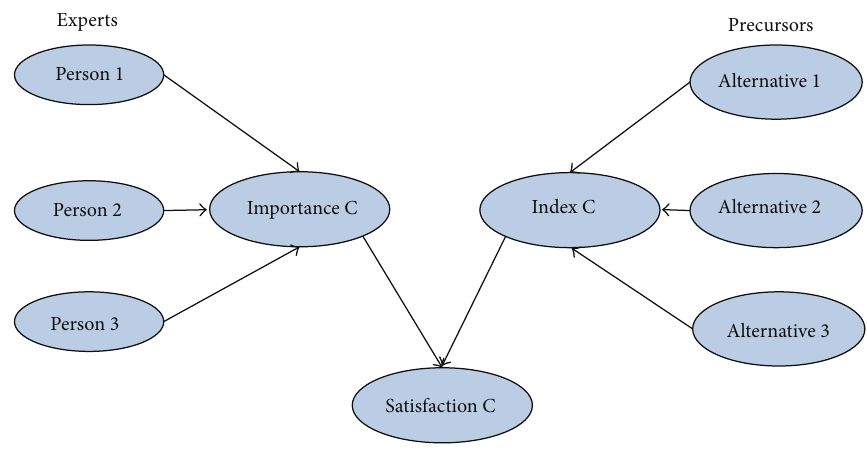
Figure 2: BBN network associated with selection of